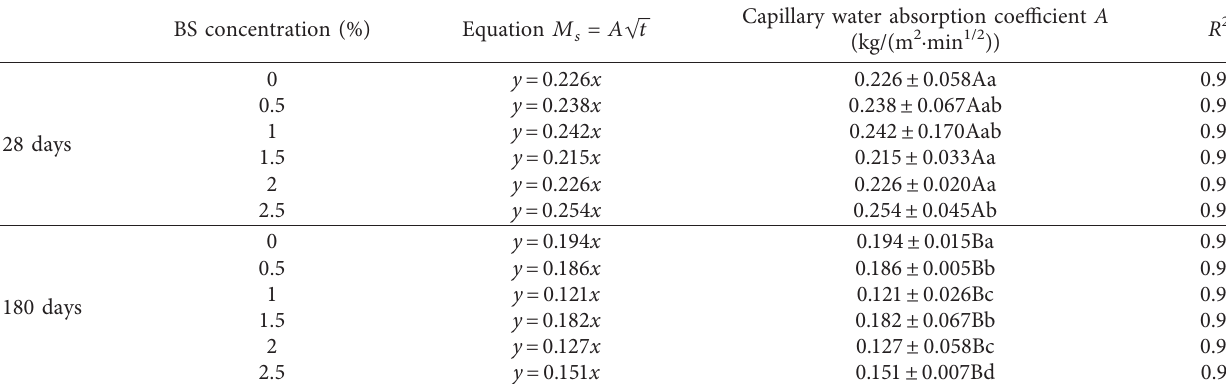
Figure 3: Cumulative mass of capillary water uptake versus time for mortars with different concentrations of biosurfactant (BS) at curing periods of 28 days (a) and 180 days (b). Table 5: Capillary water absorption coefficient A of tested mortars.